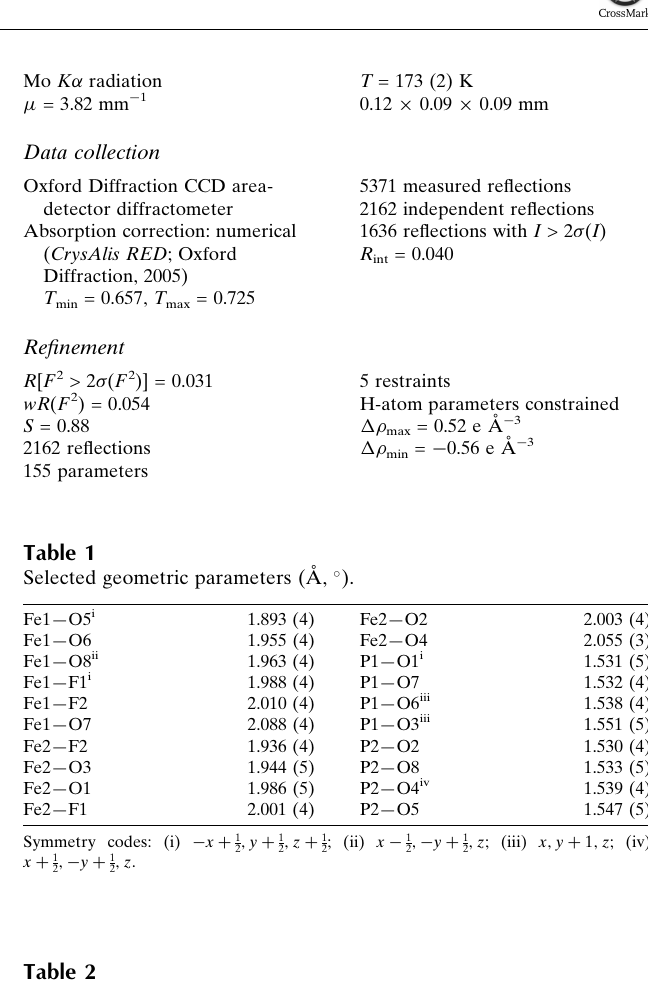
Hydrogen-bond geometry (A˚ , (cid:4)